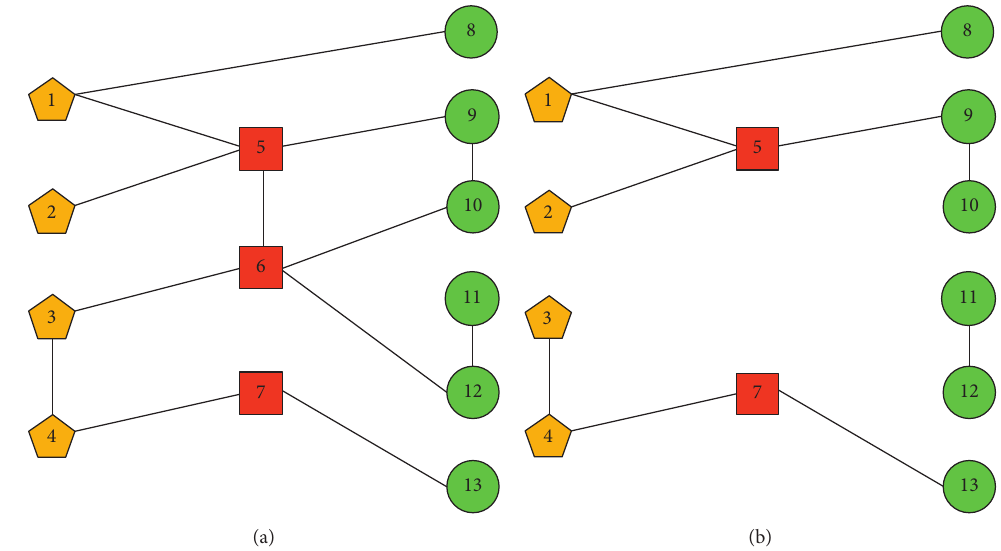
Figure 2: Illustration of LACC and SLACC. (a) Original supply network. (b) Supply network after the disruption of node